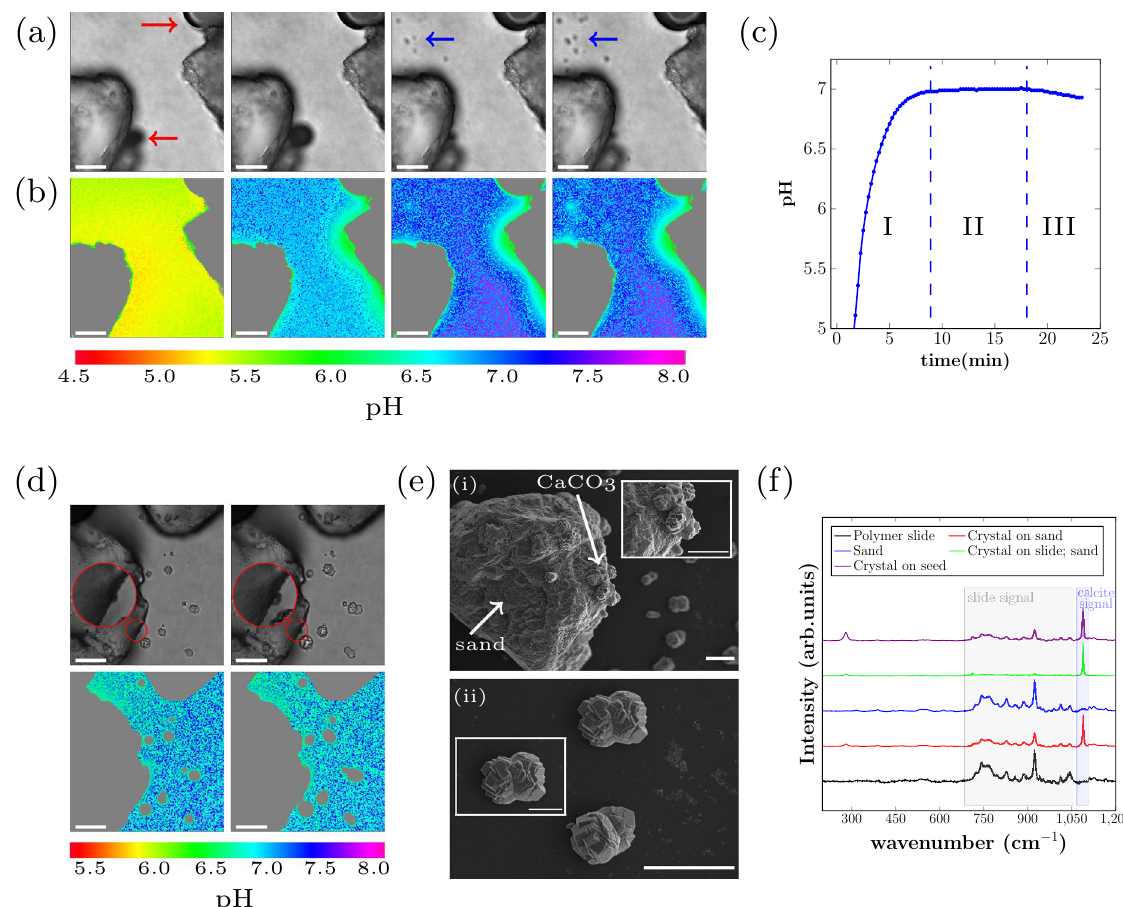
Figure 3. EICP reaction with sand present: ( a ) Brightfield images and ( b ) local pH monitoring after 2 min, 5 min, 20 min, 22 min for sample sand D2 . The images show the edges of two sand grains on the left and right side of the image, respectively. The sand grains and air bubbles are marked gray in the local pH maps. The air bubbles are marked with a red arrow in one optical micrograph. The precipitated crystals in ( a ) are marked with blue arrows. ( c ) Average pH of the local pH monitoring images shown in ( b ). ( d ) Optical micrographs (top) and local pH monitoring (bottom) of crystal growth on sand grain and on polymer slide after 30 min (left) and after 55 min(right) of the reaction. The magnified area in the optical micrographs shows a CaCO 3 crystal growing on the surface of the sand grain (note that a different position of the sample than in ( a , b ) is shown). ( e ) SEM micrographs of sample sand D2 . Sand grain with calcite crystals on the surface (top) and calcite crystals